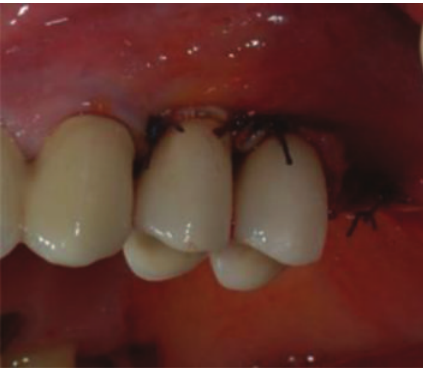
Figure 11: Postoperative radiograph indicating complete filling of the peri-implant defect.